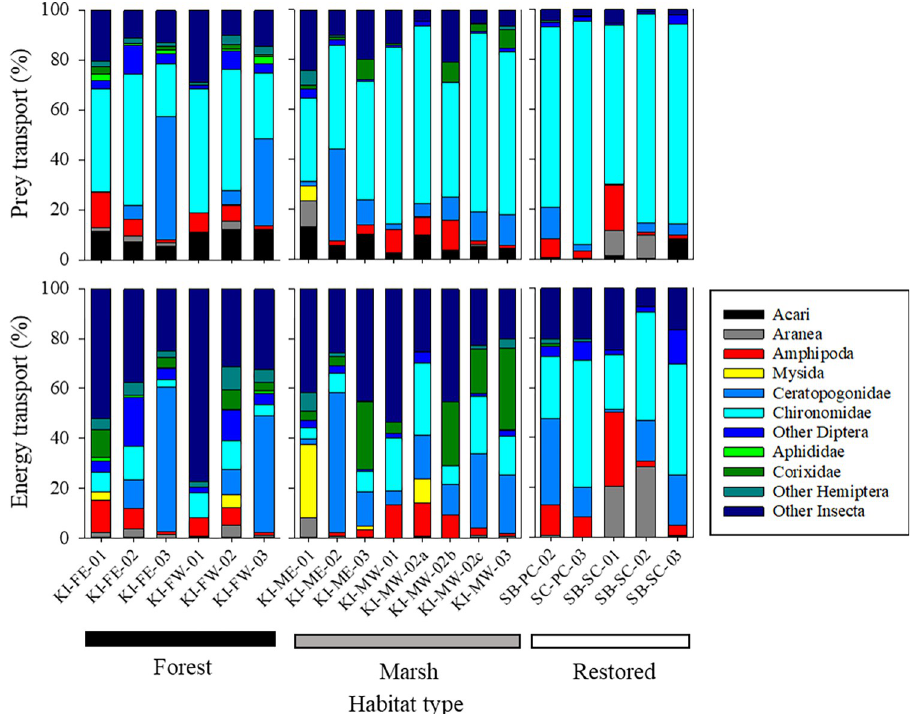
Fig 5. Percent of taxa contributing to prey transport (upper plots) and energy transport (lower plots) from restoration and reference tidal wetlands. Total tidal transport (prey × 10 5 ) and total energy transport (kJ × 10 3 ) can be found in Table